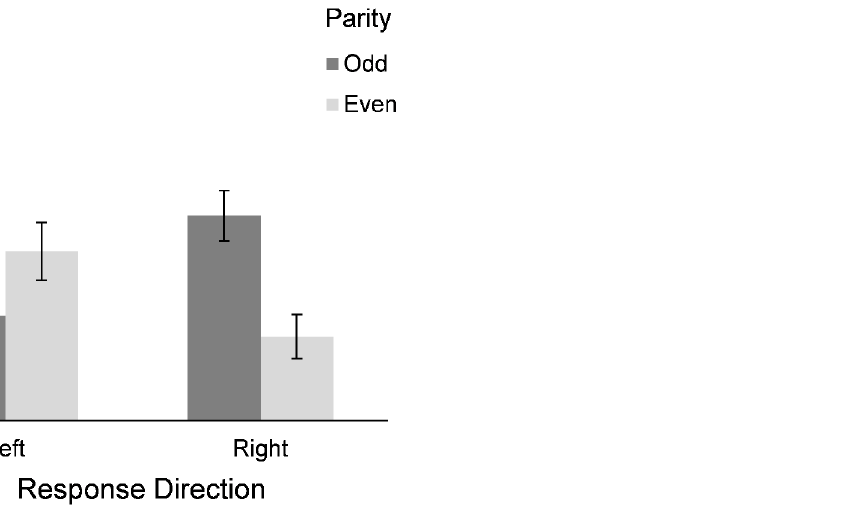
Figure 5. Interaction between response direction and parity (MARC effect) for reaction times in the parity judgment